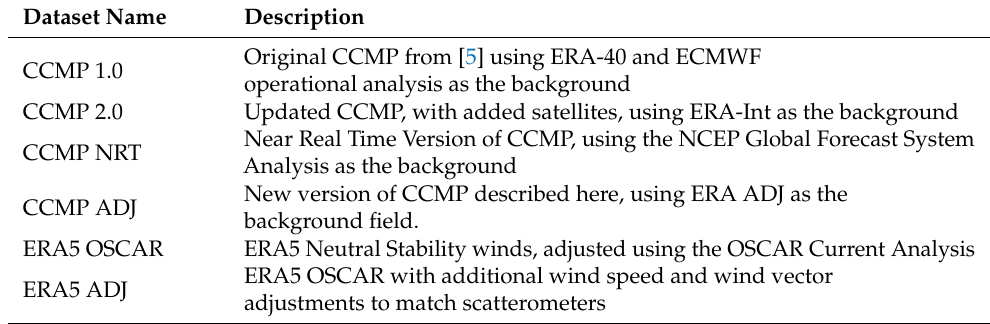
Table 2. Non-satellite datasets used or discussed in the